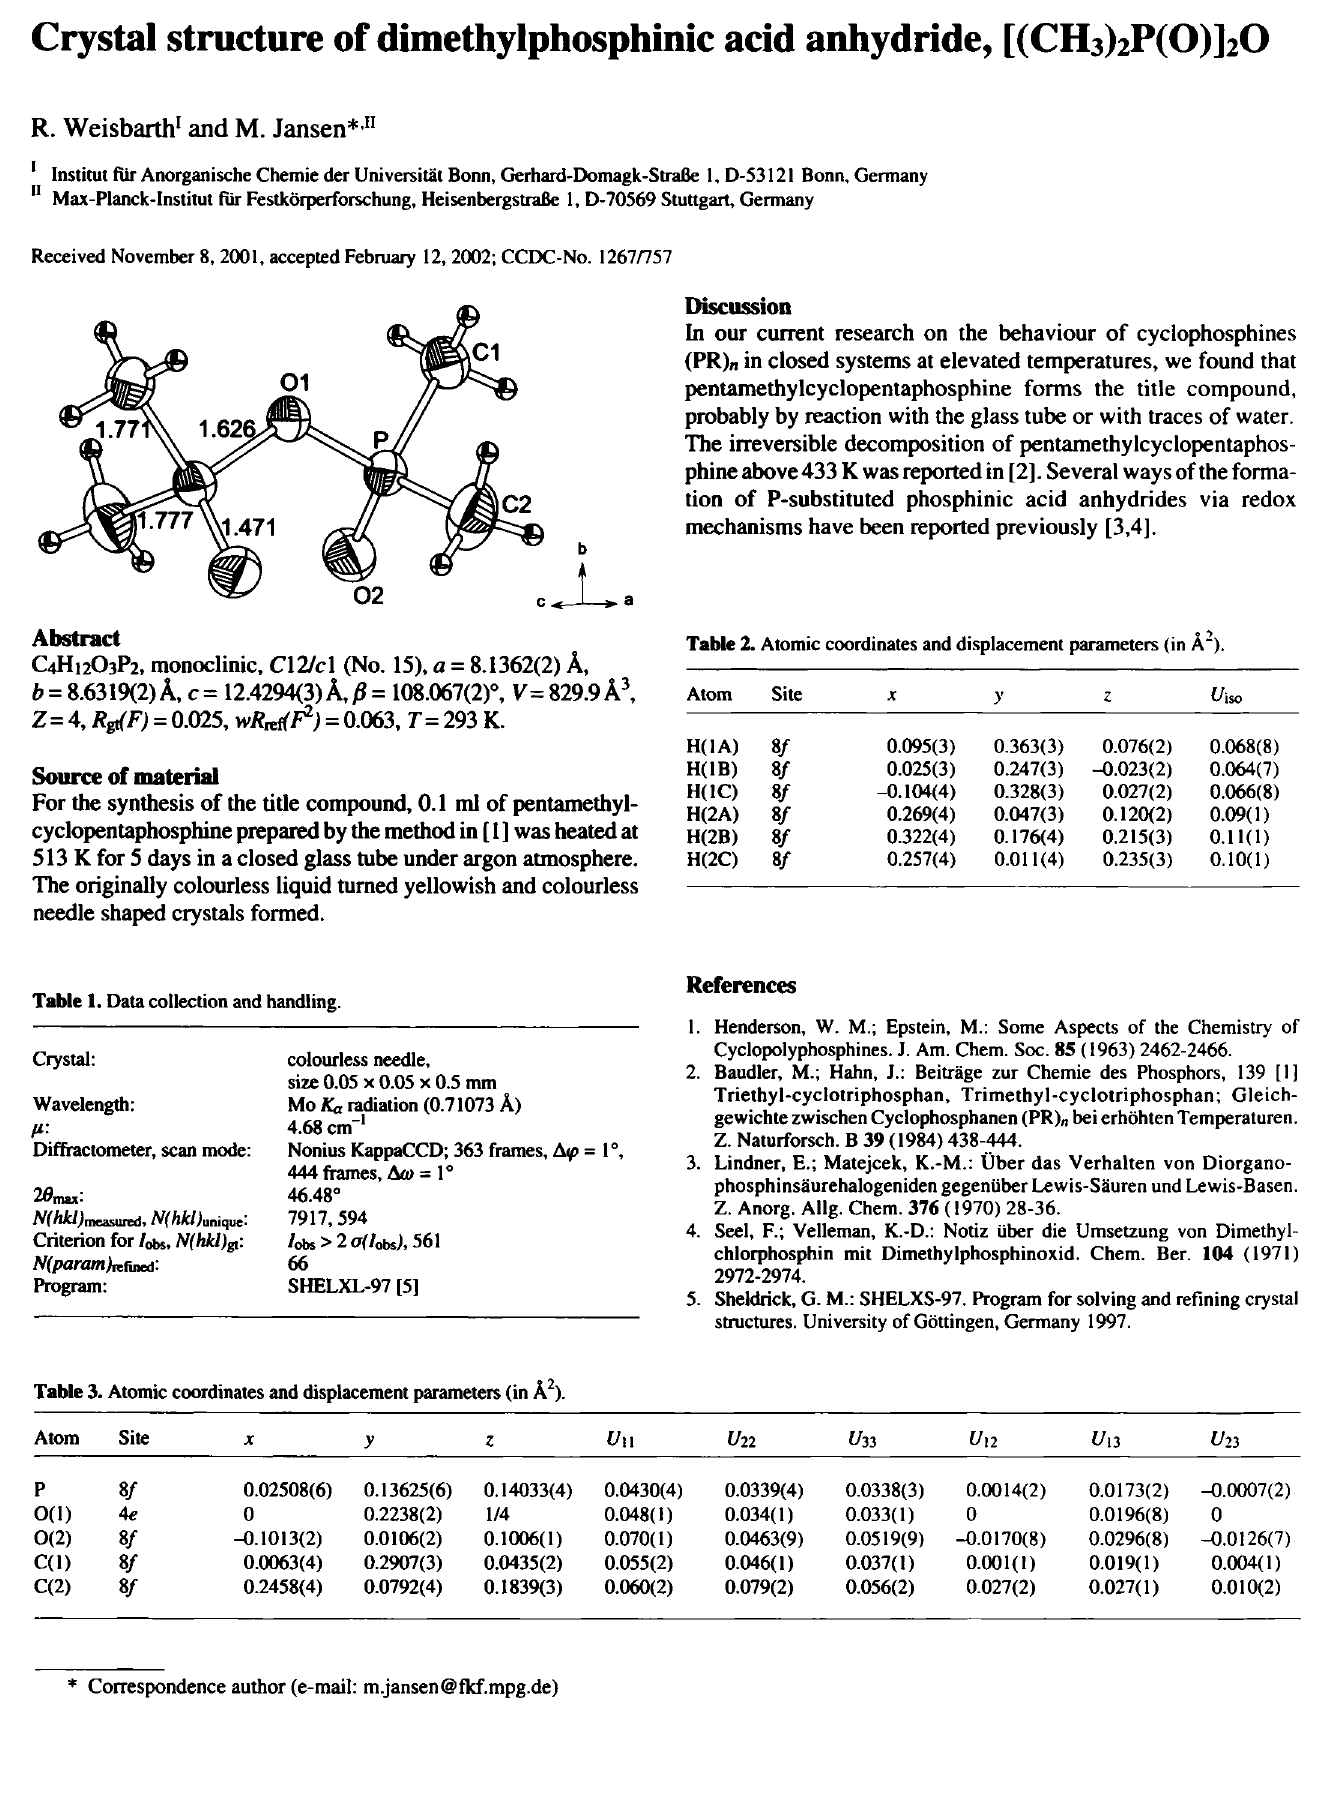
Table 3. Atomic coordinates and displacement parameters (in Ä 2